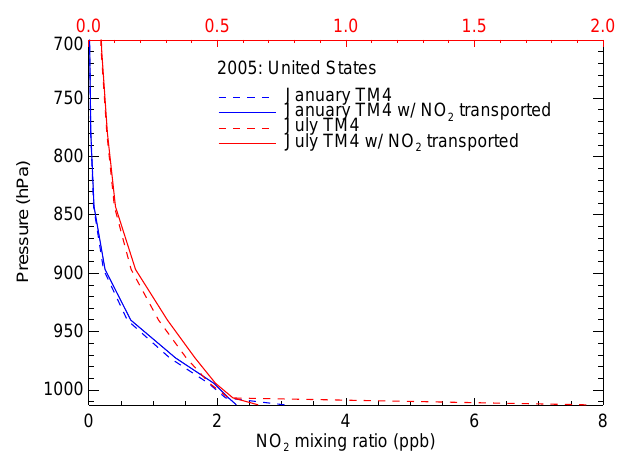
Fig. 5. Vertical profiles of NO 2 simulated with TM4 in January and July 2005. The NO 2 profiles have been sampled at 13:30 hrs local time and averaged over the United States (100.5 ◦ W-76.5 ◦ W, 31 ◦ N-51 ◦ N). The dashed lines represent the original simulations as used in DOMINO v1.02 retrievals. The solid lines represent the improved simulations with NO 2 as a transported tracer in the model. The blue and red lines indicate the simulationsforJanuaryandJuly2005,respectively.